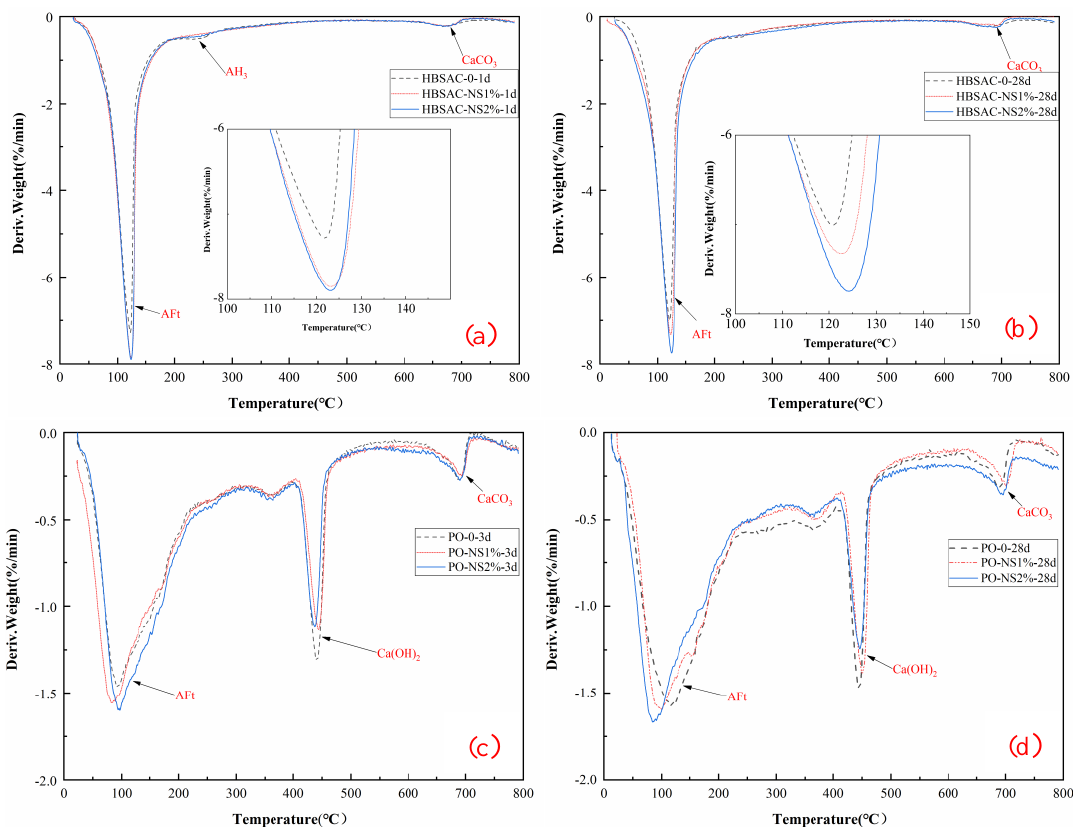
Figure 6. DTG curves of the series cement hydration products at different curing ages: ( a ) HBSAC cement at 1 day; ( b ) HBSAC cement at 28 days; ( c ) P · O 42.5 cement at 1 day; ( d ) P · O 42.5 cement at 28 days.